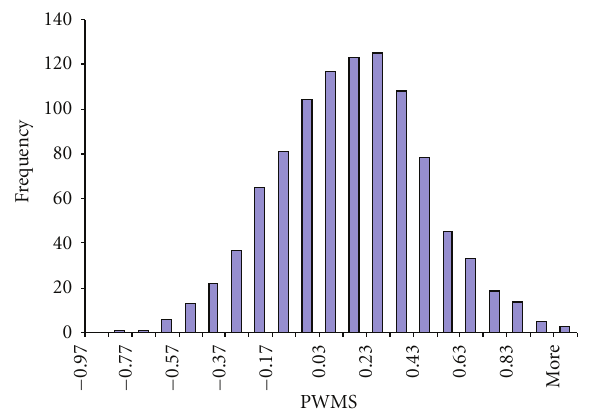
F 4: Extreme value distribution as speci�ed in (17), with 0.068884 𝜎𝜎 =